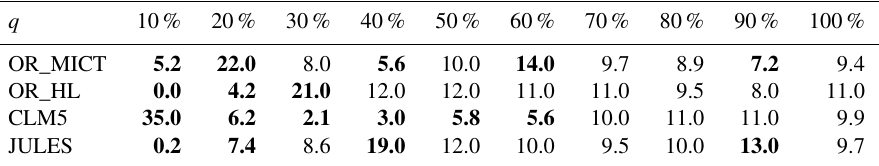
Table 3. Deciles ( q ) of the reference NPP distribution given by Fig. 1 and the percentage of NPP values in each decile observed for each LSM. An LSM whose NPP values had a distribution similar to the reference would have 10% in each decile; entries in bold indicate departures of more than 2% from 10% (decile values from 10% to 100% are: − 1 . 25 × 10 − 9 , − 5 . 15 × 10 − 11 , 4 . 58 × 10 − 11 , 1 . 30 × 10 − 9 , 5 . 67 × 10 − 9